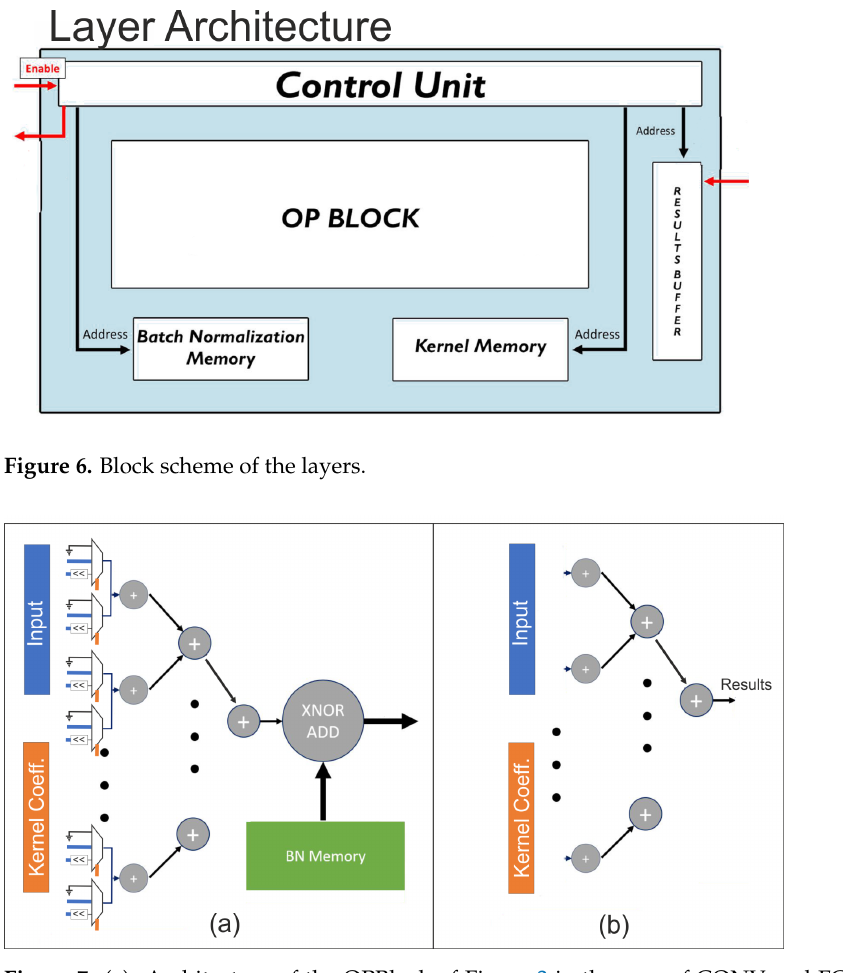
Figure 7. ( a ): Architecture of the OPBlock of Figure 3 in the case of CONV and FC Layers. Mux selects “0”, the input or the left-shifted input to emulate the products with weights. Mux with Adder tree compose the SAC operator. ( b ): PopCount tree for the OPBlock of Figure 3 in the case of GAP